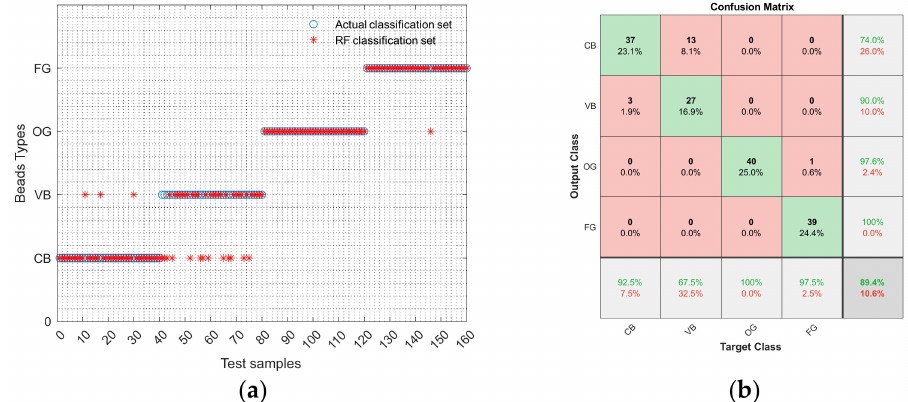
Figure 18. Prediction results of random forest. Figures shown in ( a , b ) are identification results of random forest and its confusion